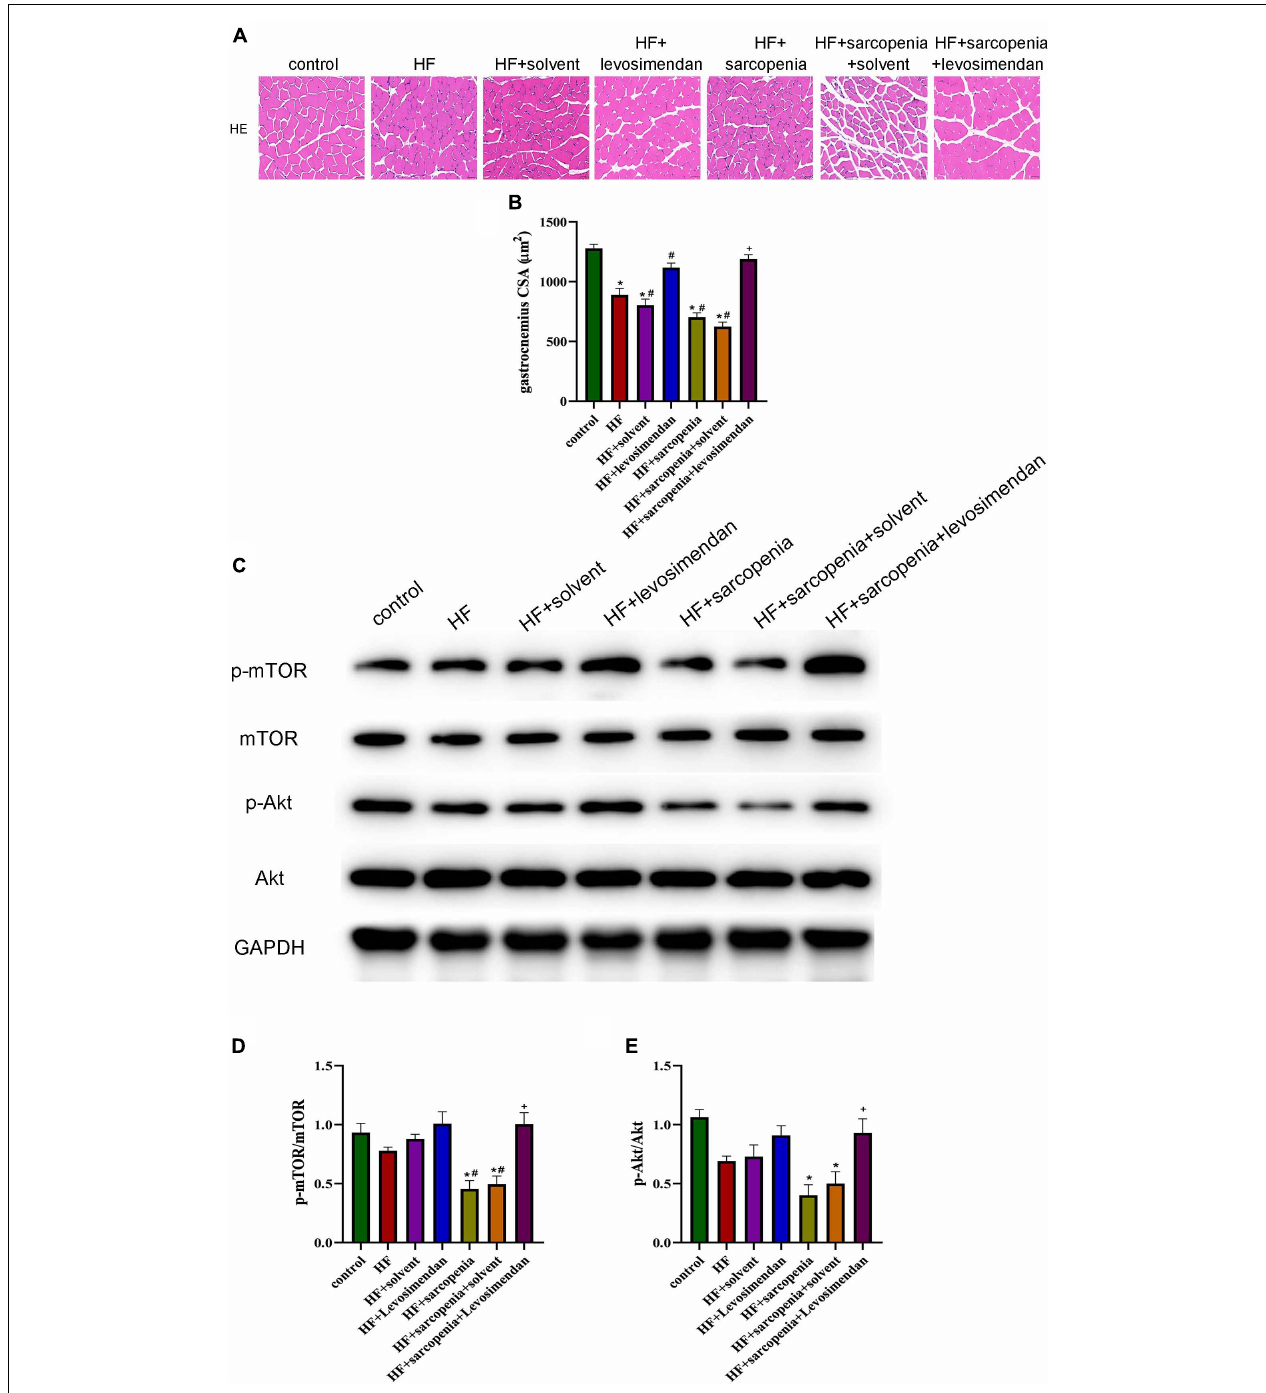
FIGURE 3 | Levosimendan improved myofiber atrophy in mice with heart failure and sarcopenia (A) HE staining of gastrocnemius. (B) CSA of muscle fibers ( µ m 2 ). (C) Detection of p-mTOR, mTOR, p-Akt, Akt expression through western blotting; GAPDH: internal reference. (D,E) The phosphorylation levels of mTOR and Akt. N = 5–12. * P < 0.05 vs. control, # P < 0.05 vs. HF, + P < 0.05 vs. HF + sarcopenia. Bar = 40 µ